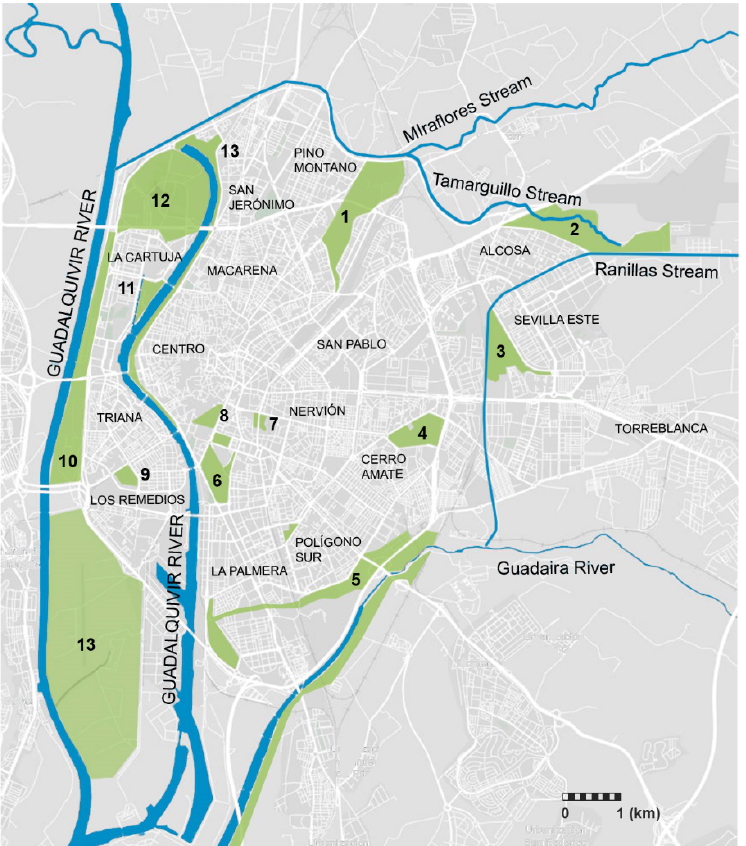
Figure 3. Seville city green system. 1. Miraflores Park; 2. Tamarguillo Park; 3. Infanta Elena Park; 4. Amate Park; 5. Guadaira Park; 6. Maria Luisa Park; 7. Buhaira Gardens; 8. Alcázares Garden; 9. Los Príncipes Park; 10. Vega de Triana Park; 11. American Garden; 12. Alamillo Park; 13. San Jerónimo Park. Source: author’s elaboration.